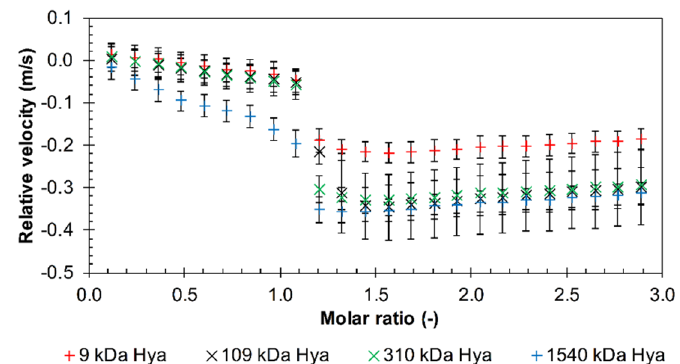
Figure 2. The relative ultrasonic velocity in dependence on molar ratio for titrations of arginine decamer in hydrochloride form into hyaluronan of different molecular weights in water (11.6 MHz, 25 °C).